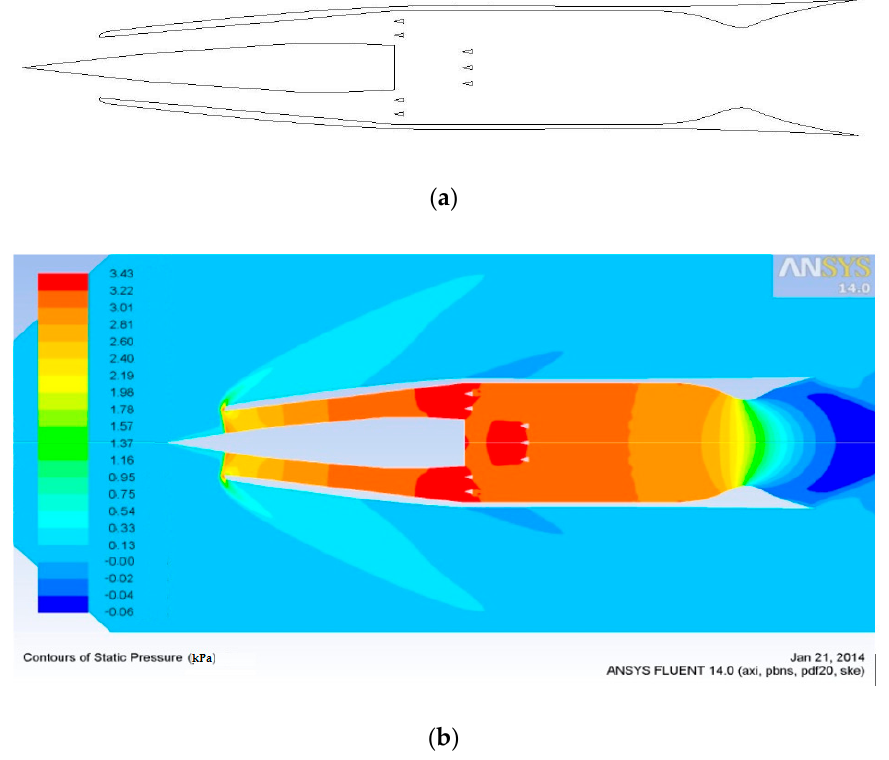
Figure 1. ( a ) Scheme of the ramjet engine geometry; and ( b ) an example pressure distribution with a single normal shockwave structure [19].